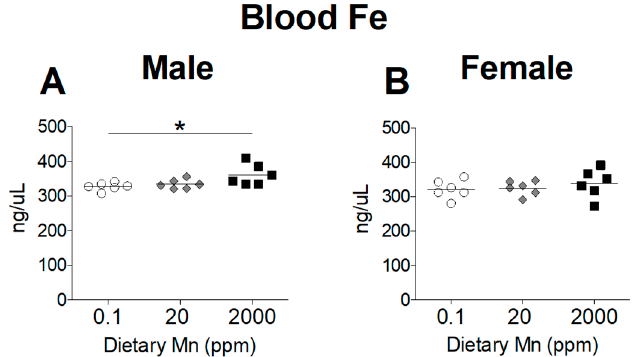
Figure 4. Whole Blood Fe levels in mice on 0.1, 20, and 2000 ppm Mn diets. Fe content measured by ICP-MS in ( A ) male and ( B ) female mice at 12 weeks of age ( n = 6 / sex). Data expressed as mean ± SEM. * p < 0.05.